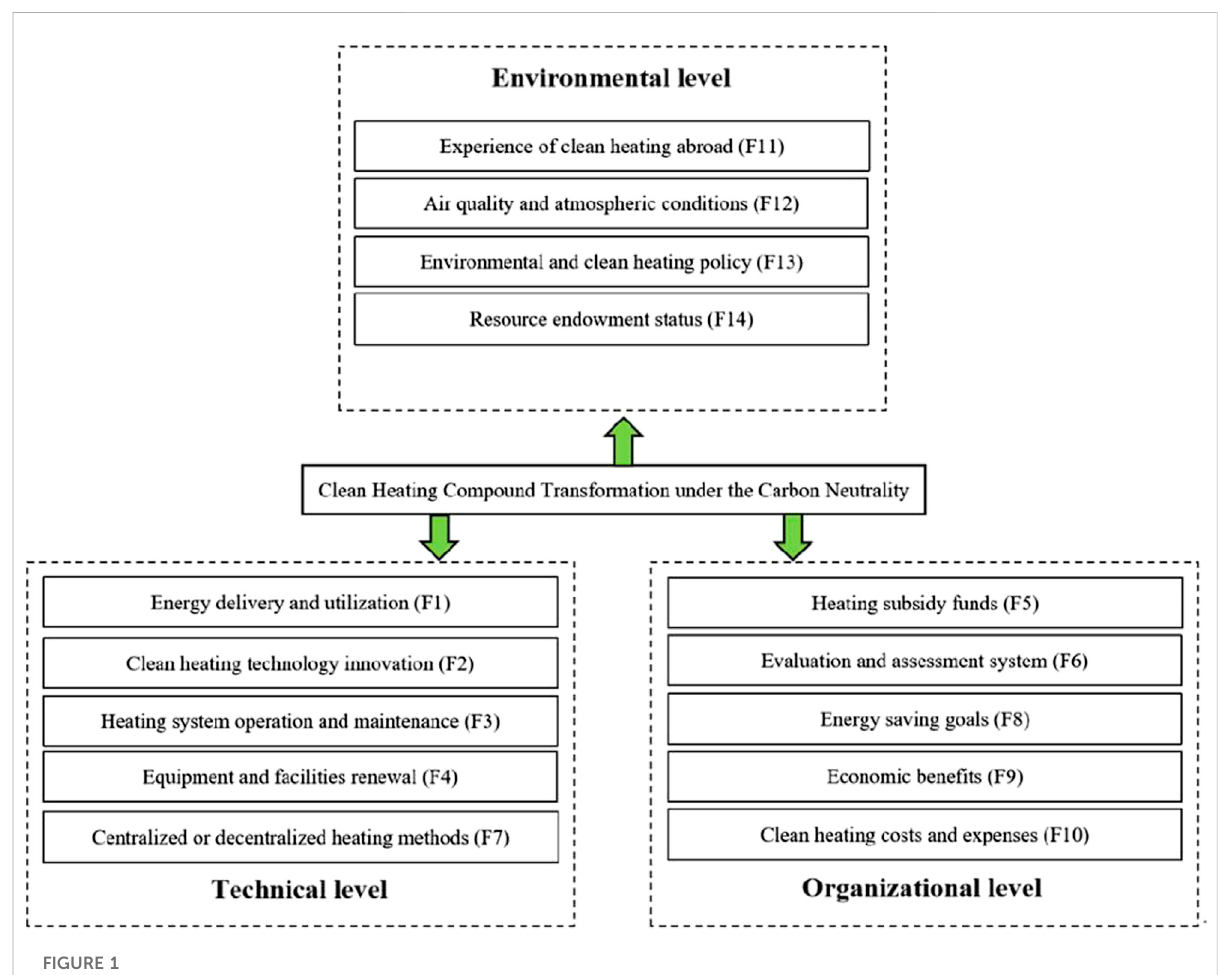
FIGURE 1 In fl uencing factors of clean heating compound